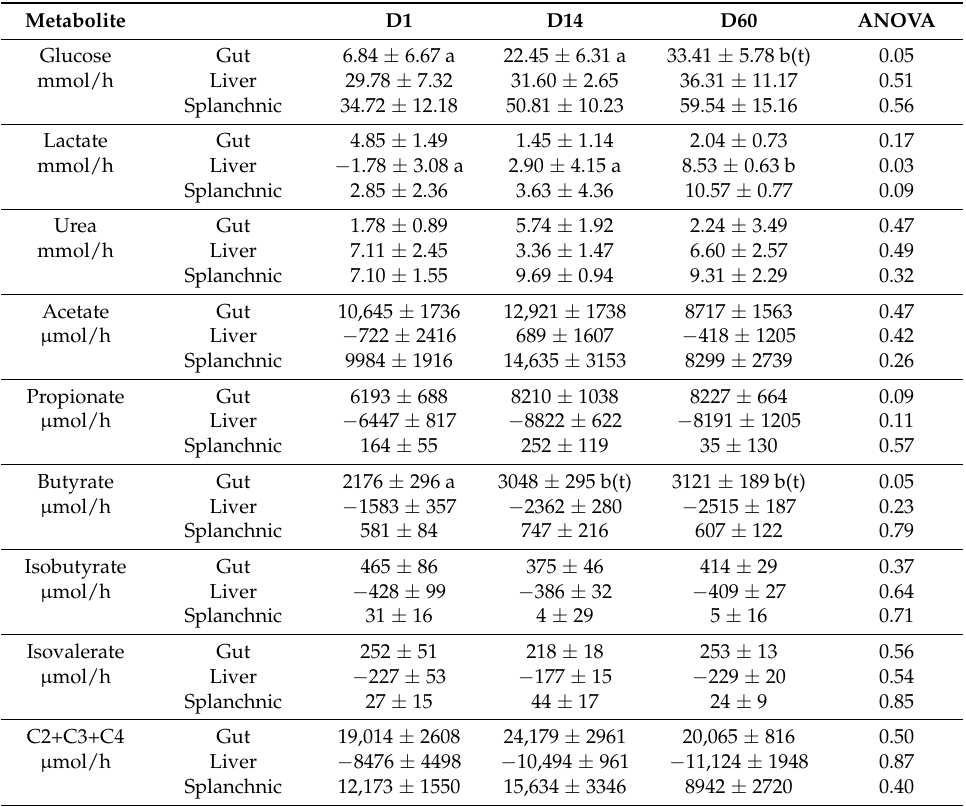
Table 4. Net gut, liver and splanchnic (gut + liver) fluxes of acetate (C2), propionate (C3), butyrate (C4), isobutyrate, isovalerate and C2+C3+C4 in the fasted state before (D1), 14 days (D14) and 60 days (D60) of adaptation to the HFHS diet.